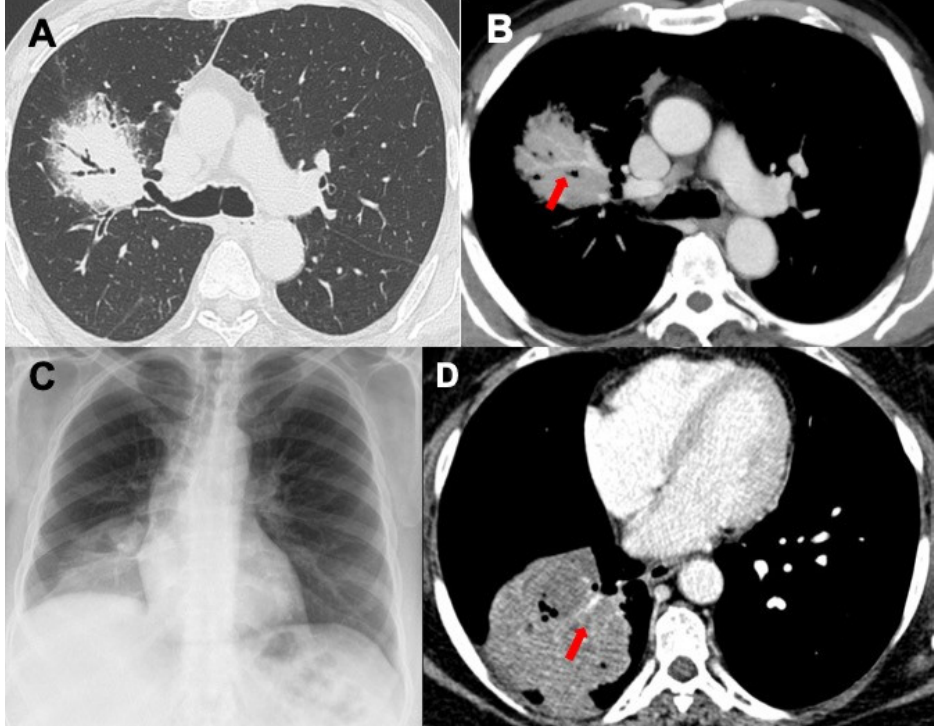
Figure 1. Chest CT of a primary MALT lymphoma expressed as consolidations with air bronchogram ( A ) and angiogram sign ( B —red arrow). Images in ( C , D ) show a DLBCL primary lymphoma manifested as a necrotic mass: chest radiograph in ( C ) shows an opacity in the right lower lobe; the chest CT study in ( D ) confirms the presence of a mass within the angiogram (red arrow) and air bronchogram